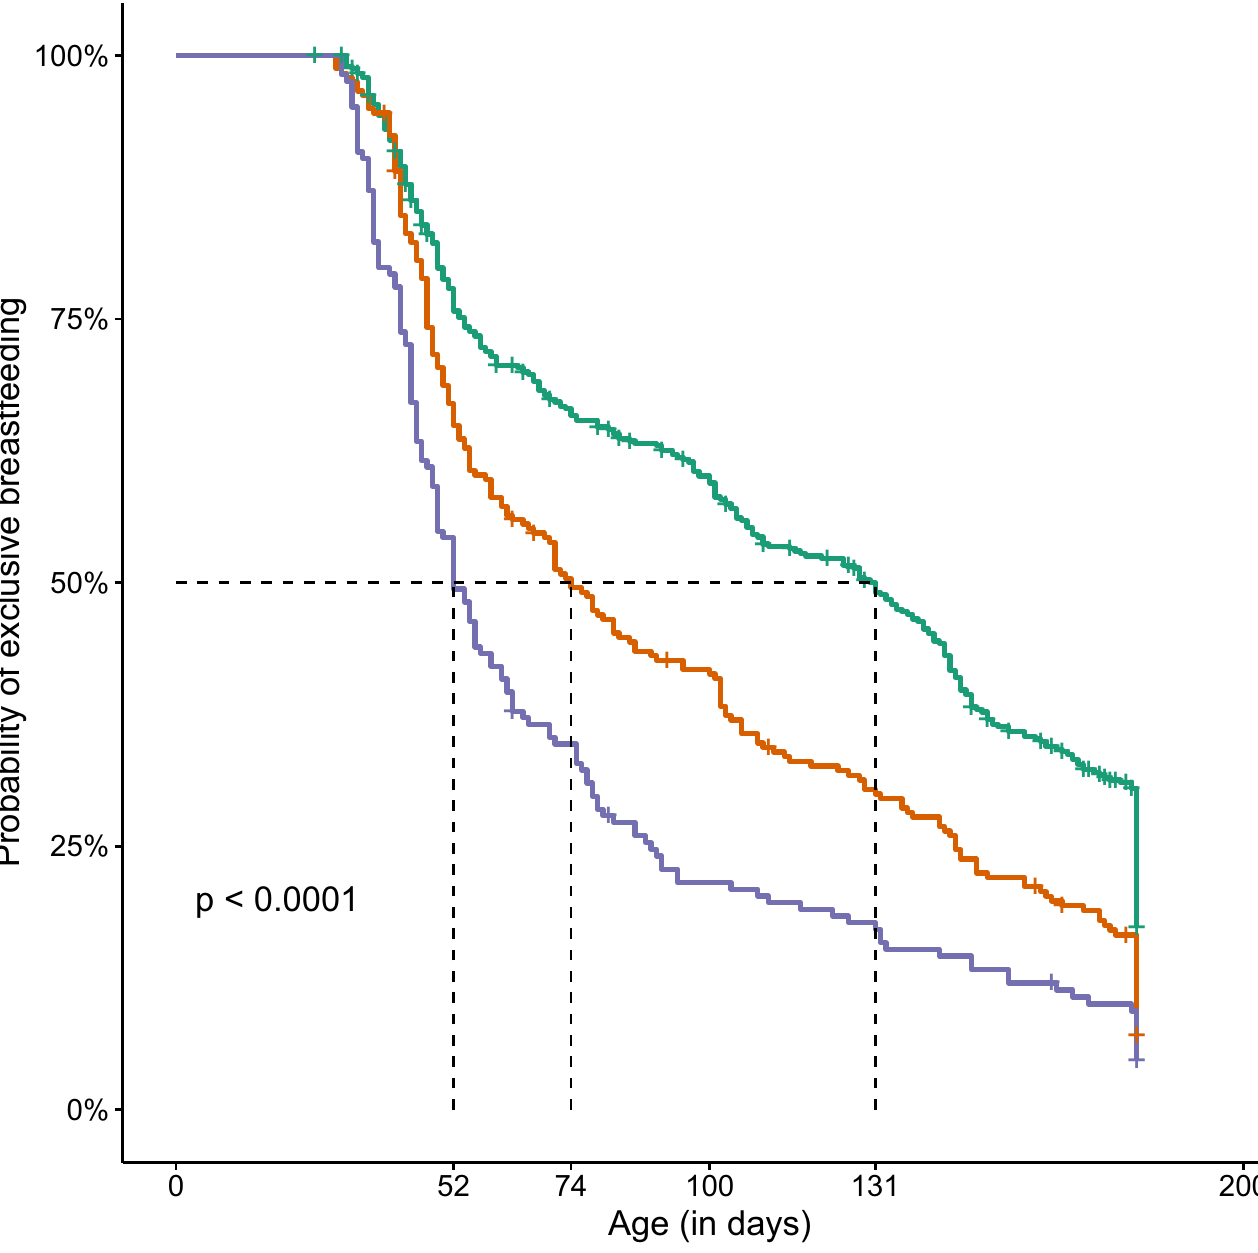
Fig 2. Kaplan-Meier of the exclusive breastfeeding time of 880 newborns from a high-risk fetal, neonatal, and infant center by groups, Brazil, 2018. Note: Risk group 1—characterized by newborns with surgical morbidities and genetic syndrome; risk group 2—characterized by preterm newborns and low birth weight. Log- rank < 0.001 EBF = exclusive breastfeeding; PBF = partial breastfeeding; BF =